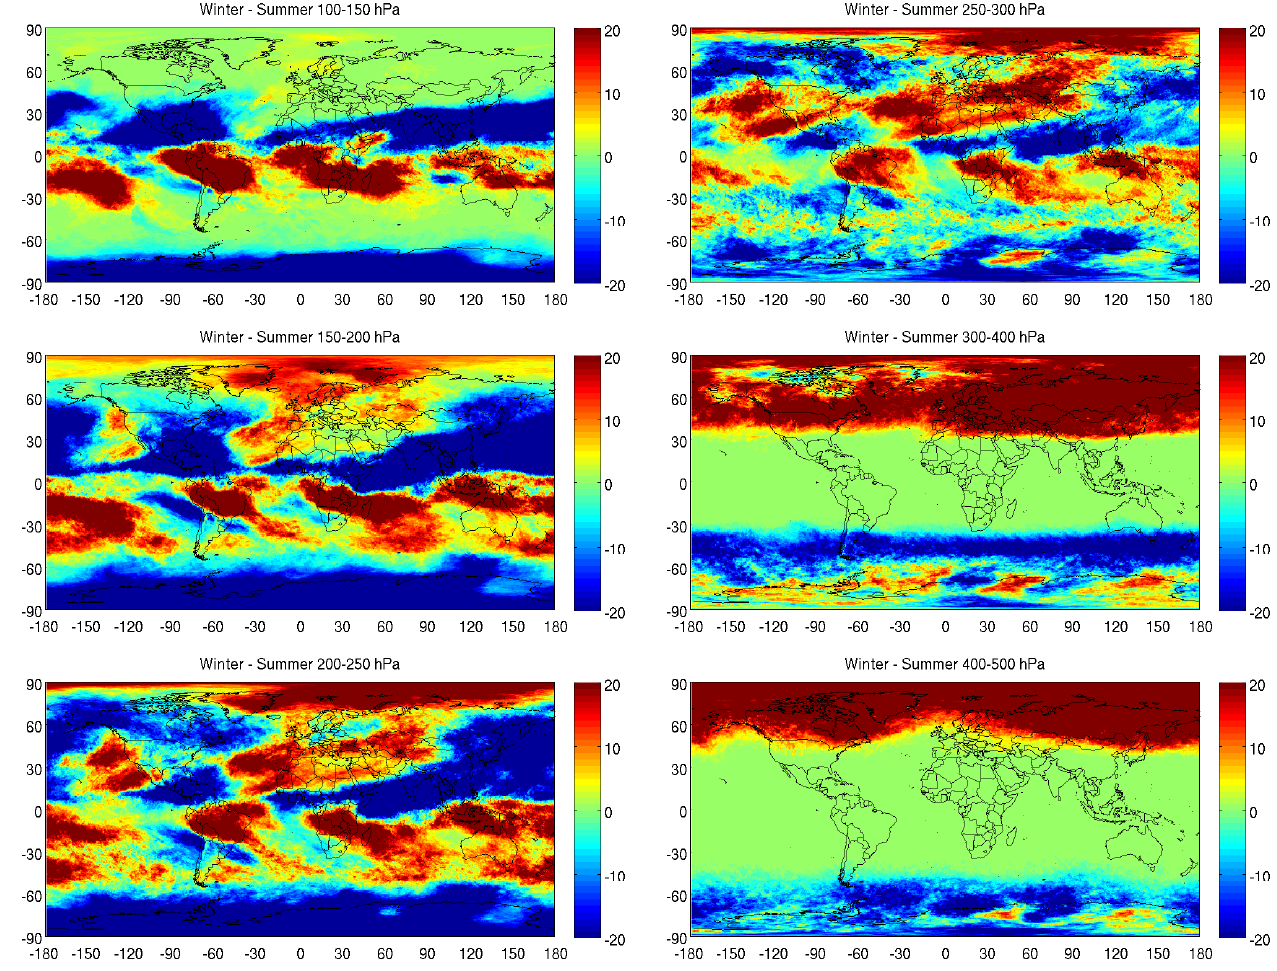
Fig. 16. Ice supersaturation occurrence frequencies (%) from ECMWF (“layer supersaturation” scheme) in the pressure layers 100–150, 150–200, 200–250, 250–300, 300–400 and 400–500hPa. Boreal winter – boreal summer. Year